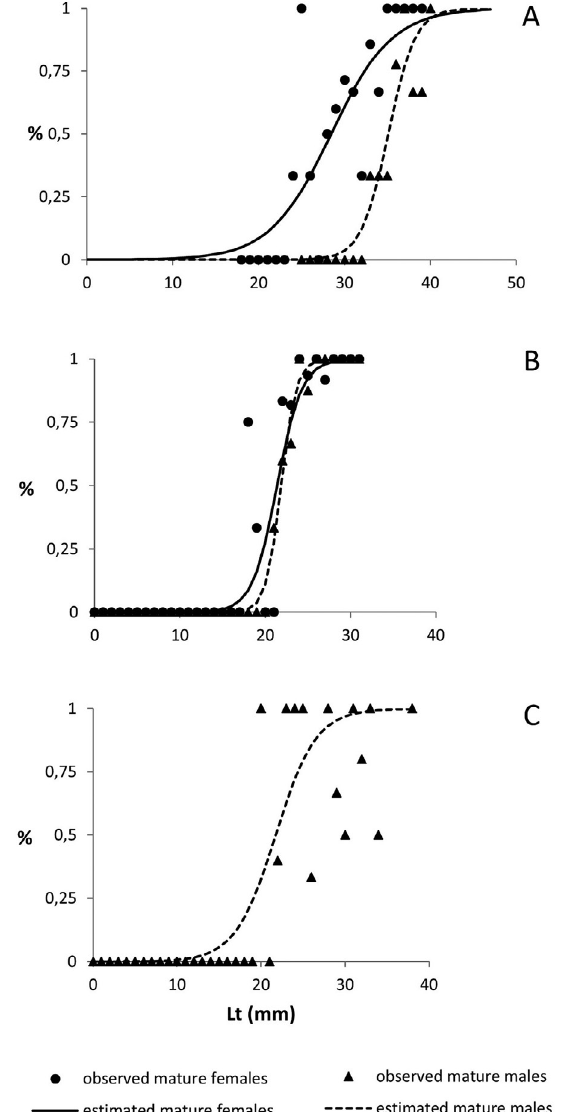
Fig. 7. – Percentage of mature females and males per length class of Aphia minuta (A), Pseudaphia ferreri (B) and Crystallogobius linearis (C). Solid lines indicate estimates of size and age at 50% maturity in females, and dashed lines indicate estimates of size and age at 50% maturity in